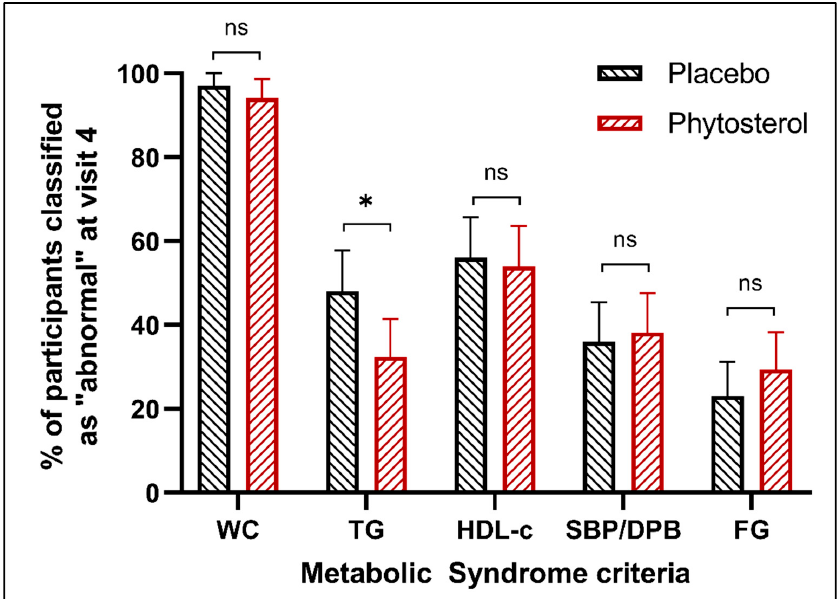
Figure 3. Distribution of participants (%) with ‘abnormal’ levels of waist circumference, triglycerides,